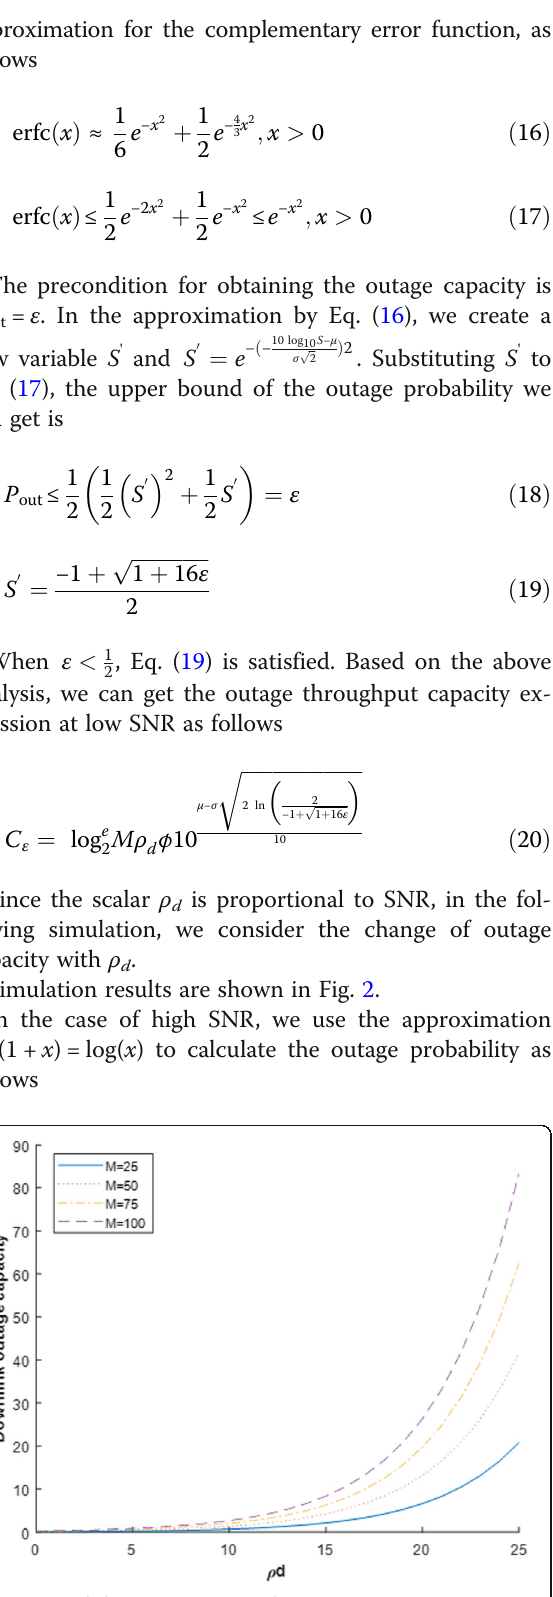
Fig. 2 Downlink outage capacity at low